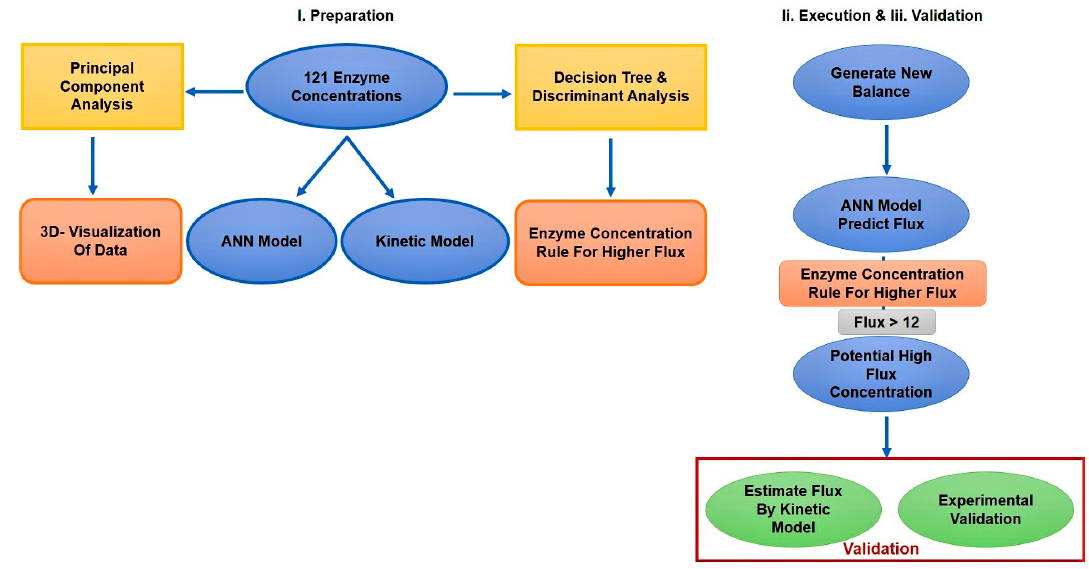
Figure 2. Figure 2. The methodology followed to obtain the new flux values from the generated enzyme concentration.